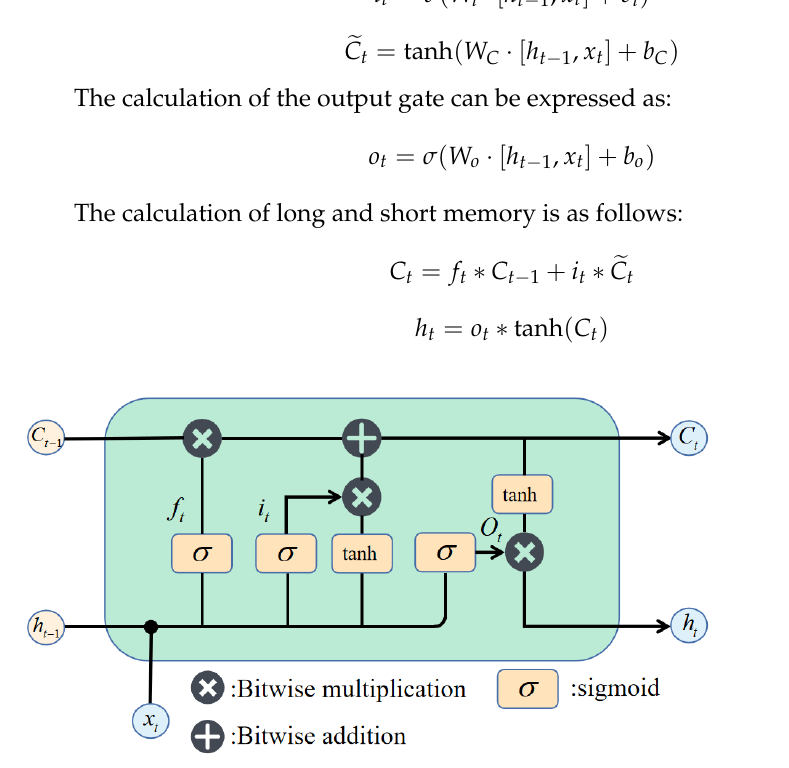
Figure 5. Basic structure of LSTM network.